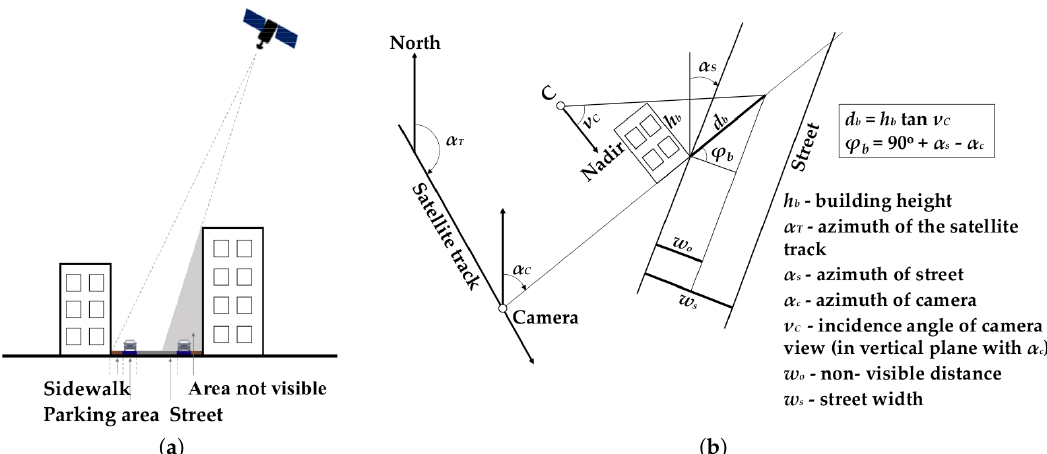
Figure 11. Satellite image acquisition: ( a ) profile-view illustration of visible and non-visible areas (satellite track parallel with street azimuth and a null in-track viewing angle) and ( b ) satellite viewing geometry for street